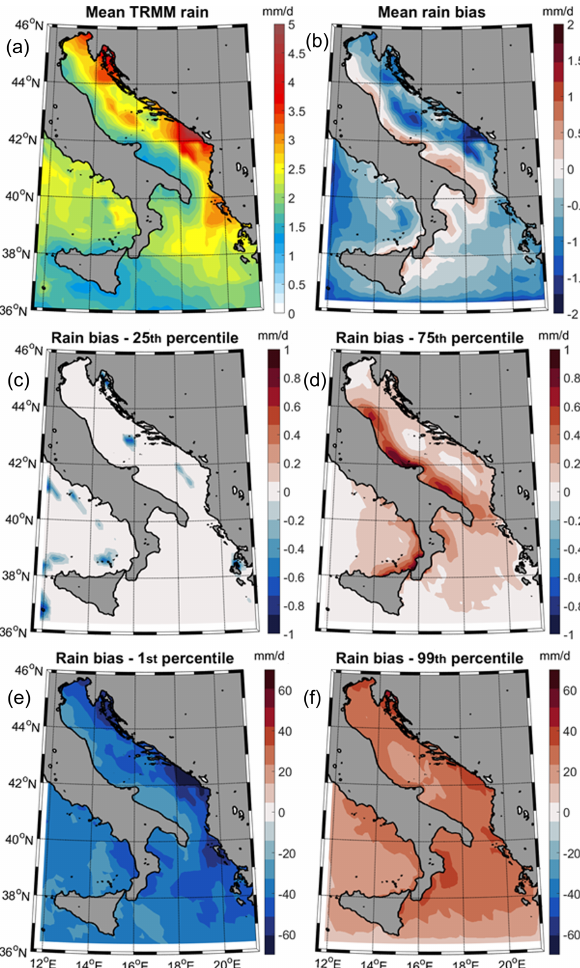
Figure 9. The same as in Fig. 3 but for the daily TRMM rain remote sensing data over the sea during the 1998–2017